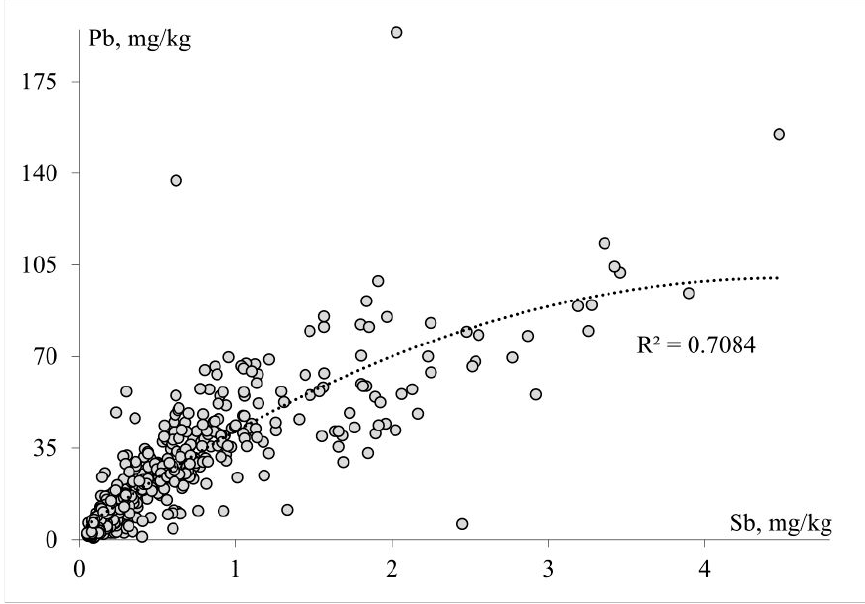
Figure 17. The correlation between Pb and Sb in lake sediments of Karelia (author data).